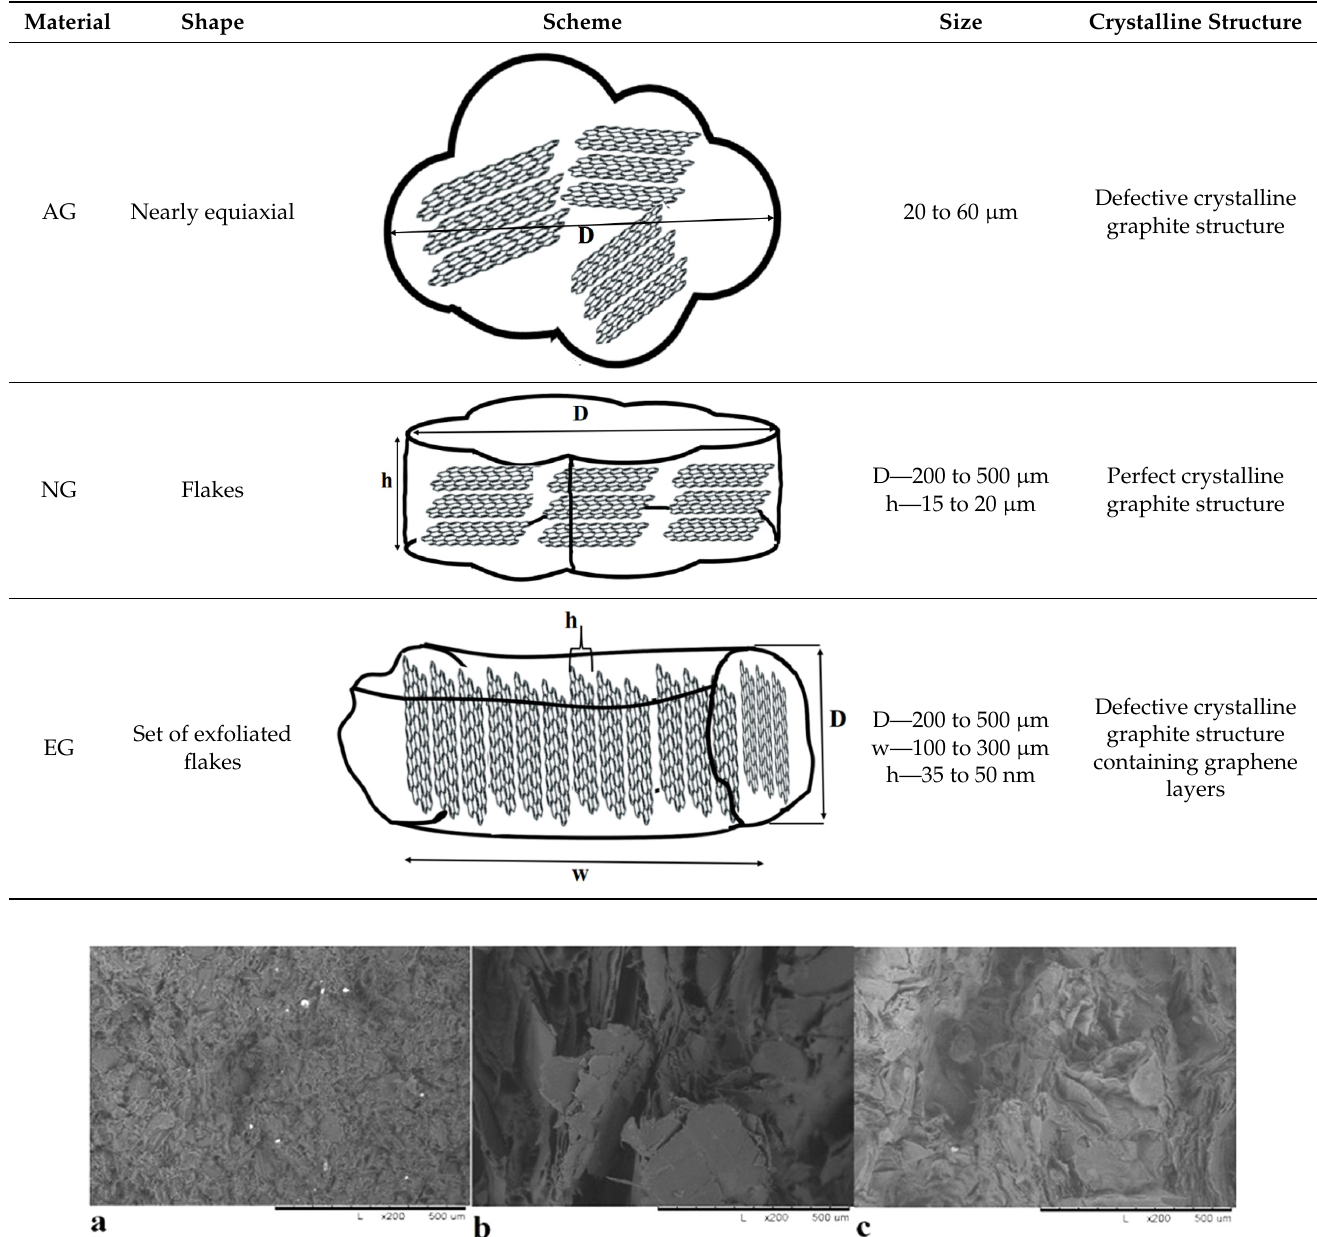
Table 1. Comparison of the graphite materials structure.